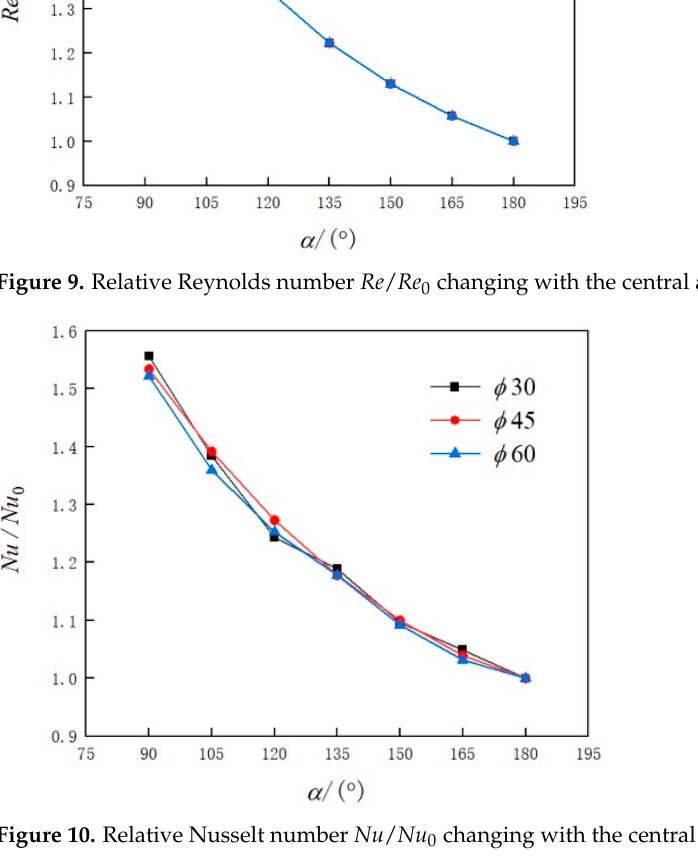
Figure 11. Relative Nusselt number Nu / Nu 0 changing with the central angle α for helical pipes. Figure 12. Relative frictional resistance coefficient f / f 0 changing with the central angle α for straight pipes.